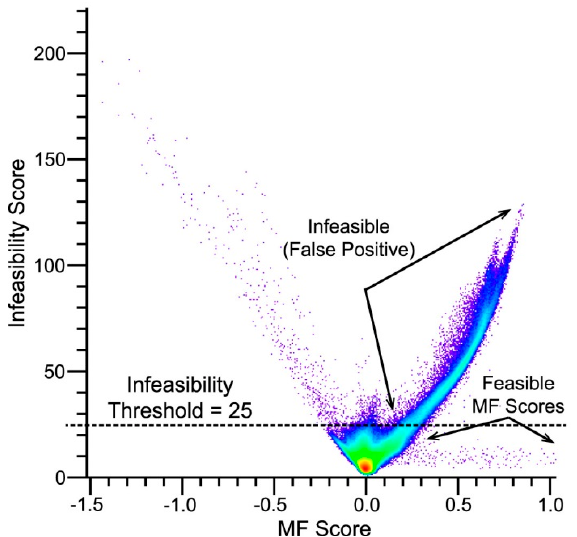
Figure 4. Example of matched filter (MF) score vs. Infeasibility score scatterplot illustrating the selection of an infeasibility threshold at the edge of the data background distribution separating feasible and infeasible MF scores. The class shown here is shortwave infrared Class 2.